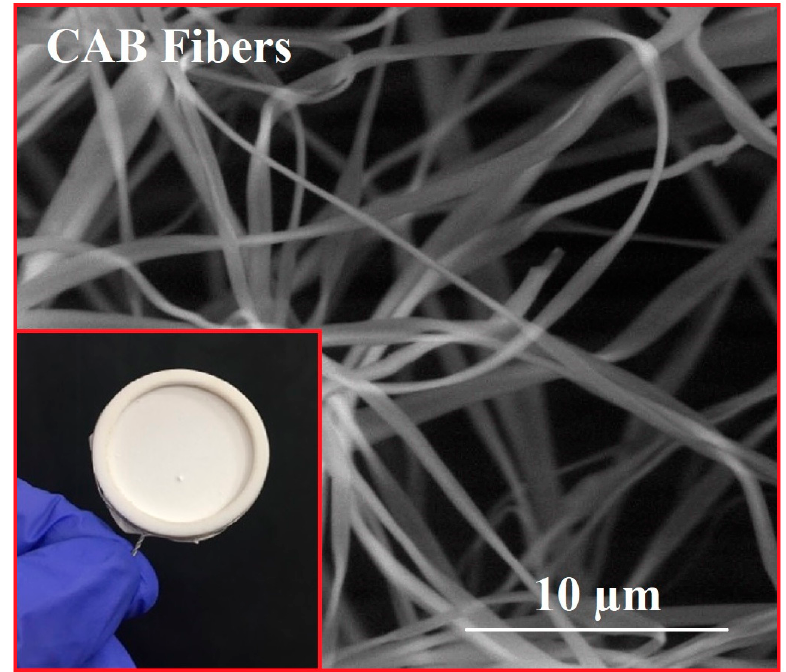
Figure 3. Scanning electron microscope (SEM) image of cellulose acetate butyrate (CAB) microfiber mats obtained by the electrospinning method from a mixture of 32% polymer and 2-methoxyethanol. This micrograph confirms the formation of a membrane with uniform and smooth microfibers having dimensions of 1 µm. After this, star-shaped crystals and nanorods were grown on these membranes by dipping and hydrothermal methods, followed by calcination at 240 °C in the air for 1 h. SEM images shown in Figure 4 for hybrid CAB/ZnO nanostructures obtained by the dipping method indicate a structure composed of ZnO nanocrystals with a star-like shape. It can be observed that the same structure was maintained after calcination at 600 °C in N 2 atmosphere for 30 min for M1 (T) nanostructure (Figure 4).